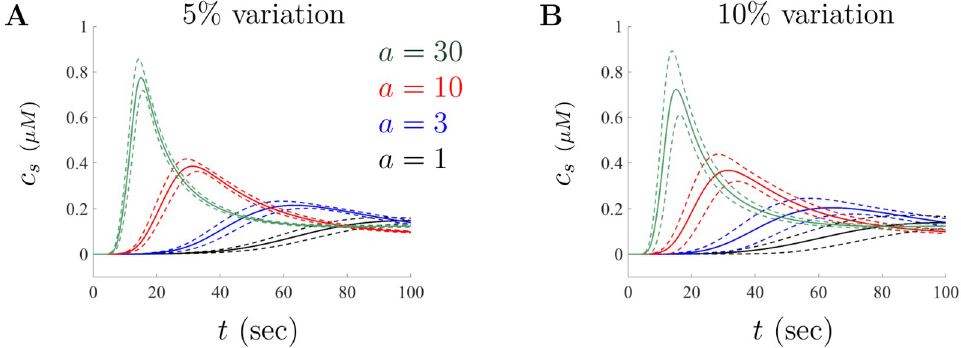
Fig 9. Model solutions under variation of parameters. The mean and corresponding standard deviations when the model is simulated for n = 100, 000 stochastically chosen parameter sets. The solid curves corresponds to the mean response and the dashed curves are the standard deviation above and below the mean. A and B illustrate the uncertainty in solutions when parameters are selected from a set with 5% and 10% deviation from the large doses base values given in Table 2,